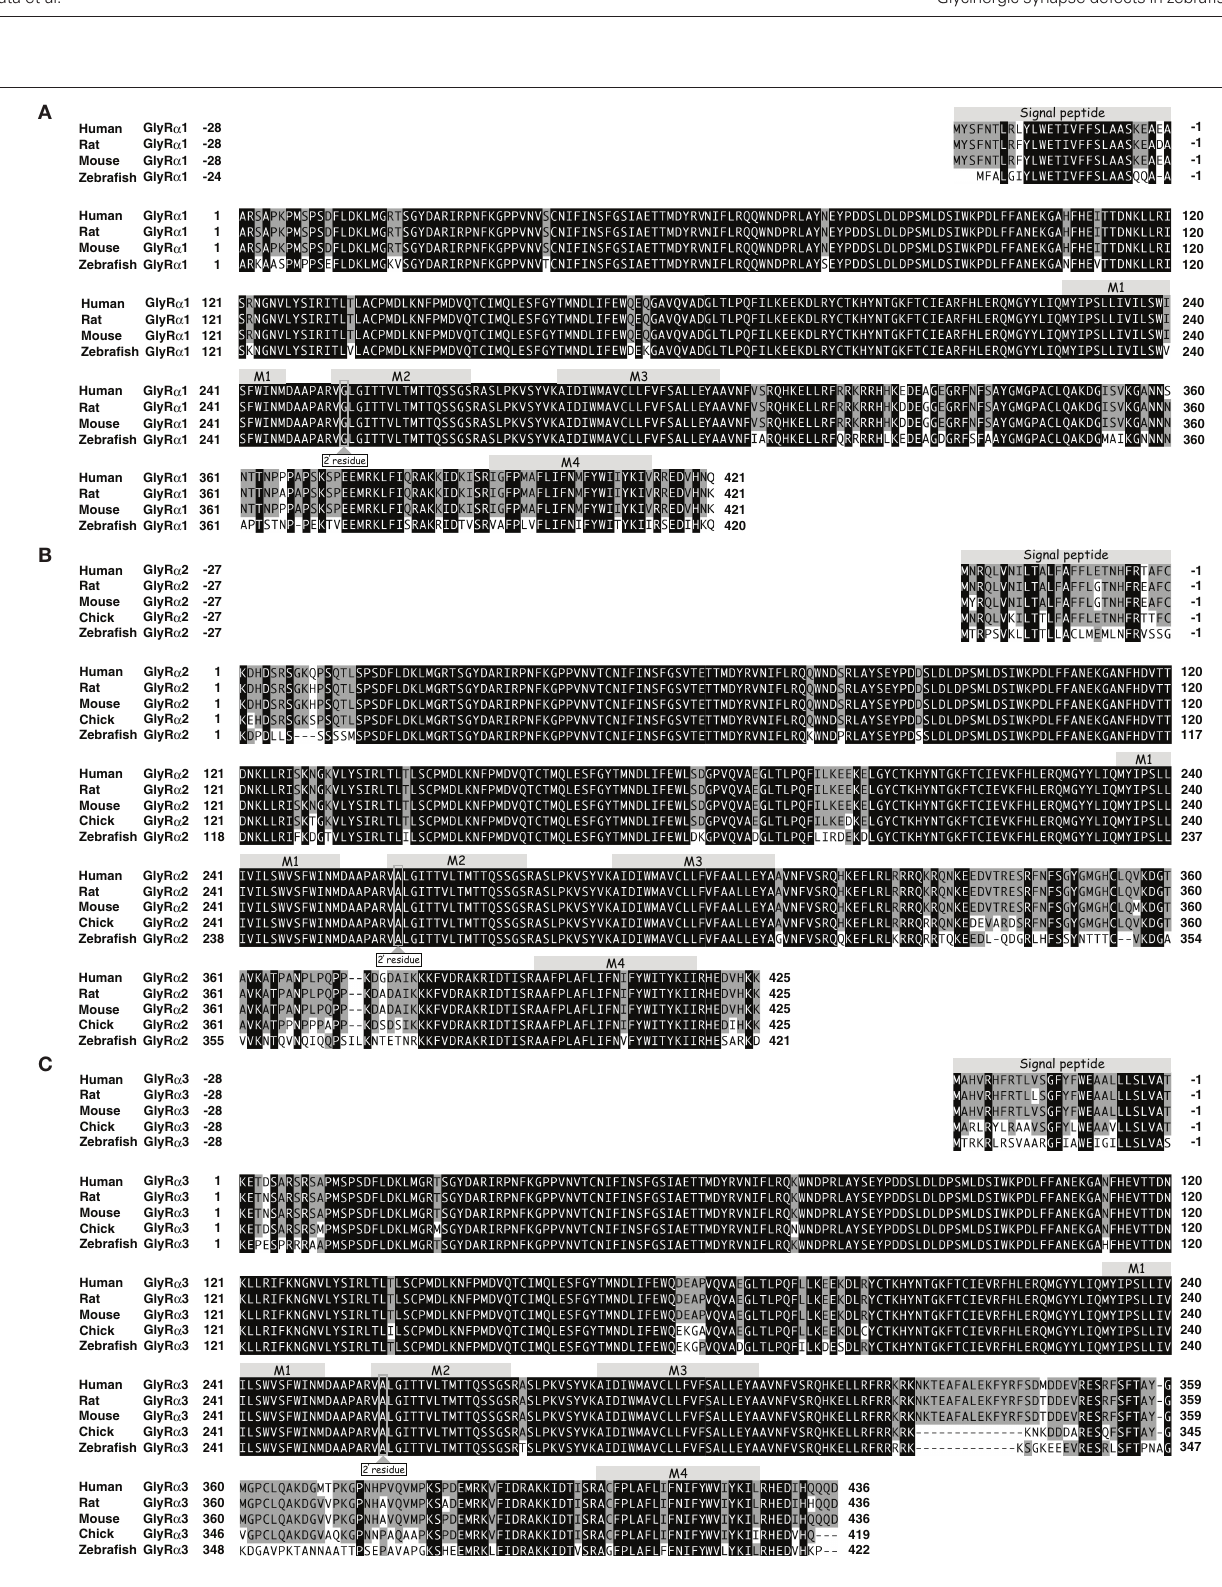
peptides are denoted by negative numbering. (B) Protein sequence alignment of human (NP_002054), rat (NP_036700), mouse (NP_906272), chick (XP_001234291) GlyR α 2 with zebrafi sh (GQ406228) GlyR α 2. (C) Protein sequence alignment of human (NP_006520), rat (NP_446176), mouse (NP_536686), chick (XP_420527) GlyR α 3 with zebrafi sh (NP_694497) GlyR α